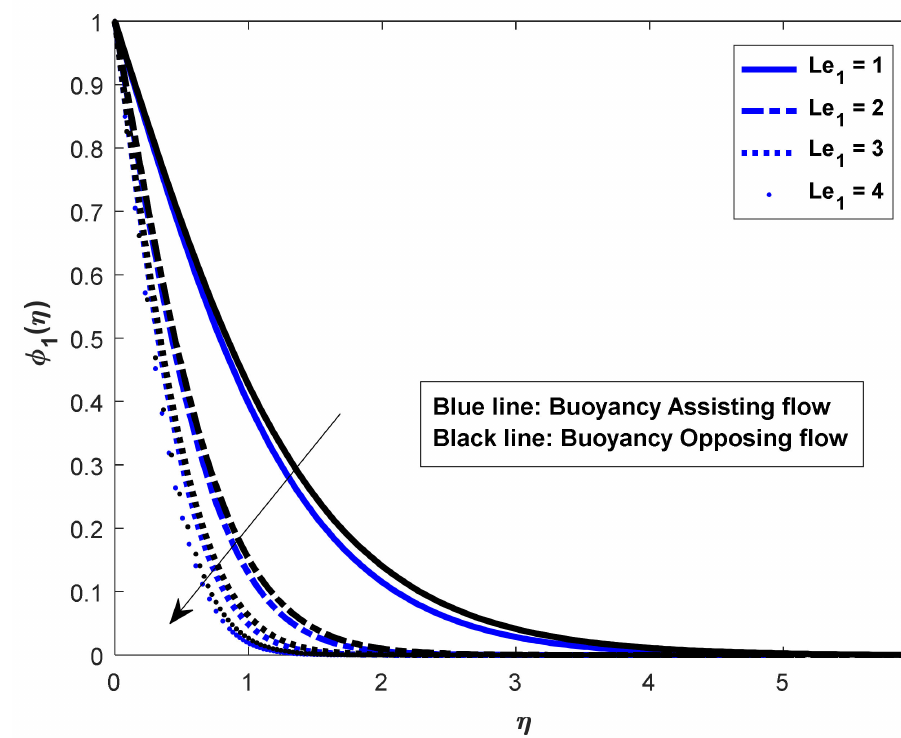
Figure 23. Le 1 on salt_1